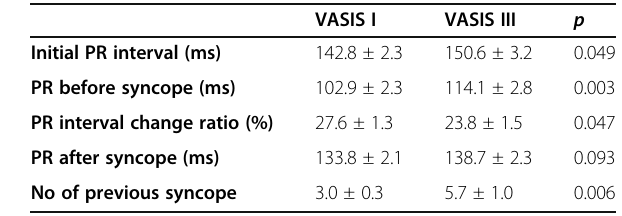
Table 2 PR interval duration dynamics and average No of syncope in patient history in relation to the VASIS